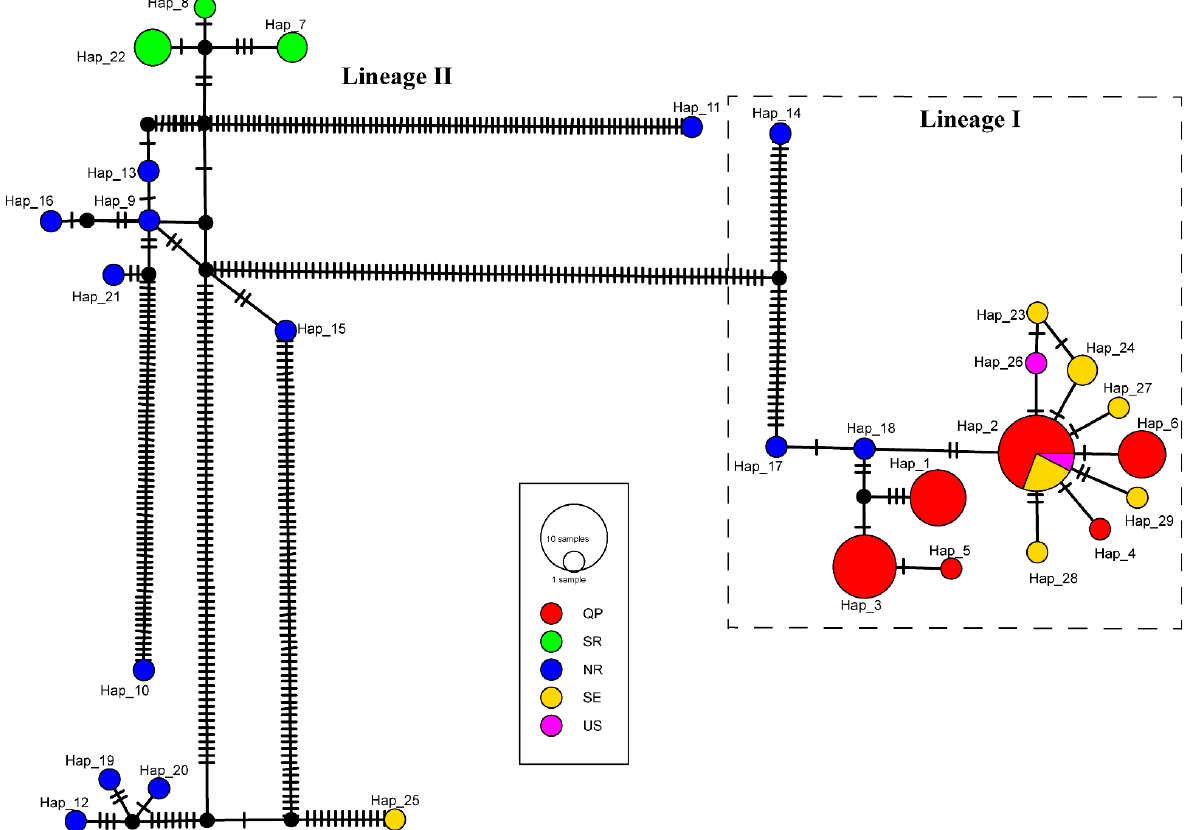
Figure 3. The haplotype network of Lumbriculus variegatus lineages based on the concatenated sequences of gene COI and 16S. “Hap” denotes Haplotype; subsequent numbers mean haplotype number; QP, SR, NR, SE, and US portions in the circle represent the Tibetan region, Southern China, Northeast China, Sweden, and North America.